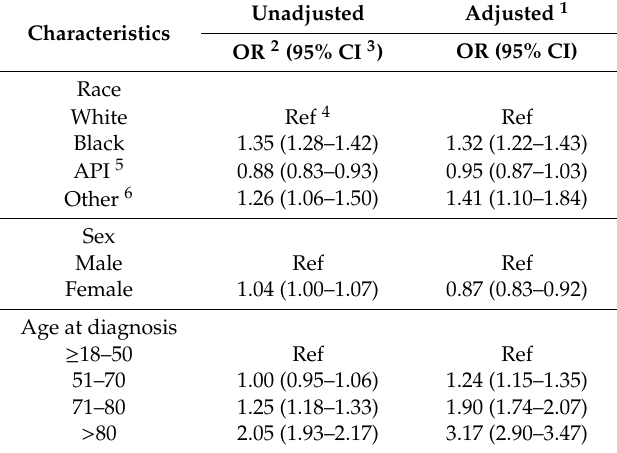
Table 3. Unadjusted and adjusted associations of the logistic regression models between race and cause specific death in patients with colorectal cancer in the US during